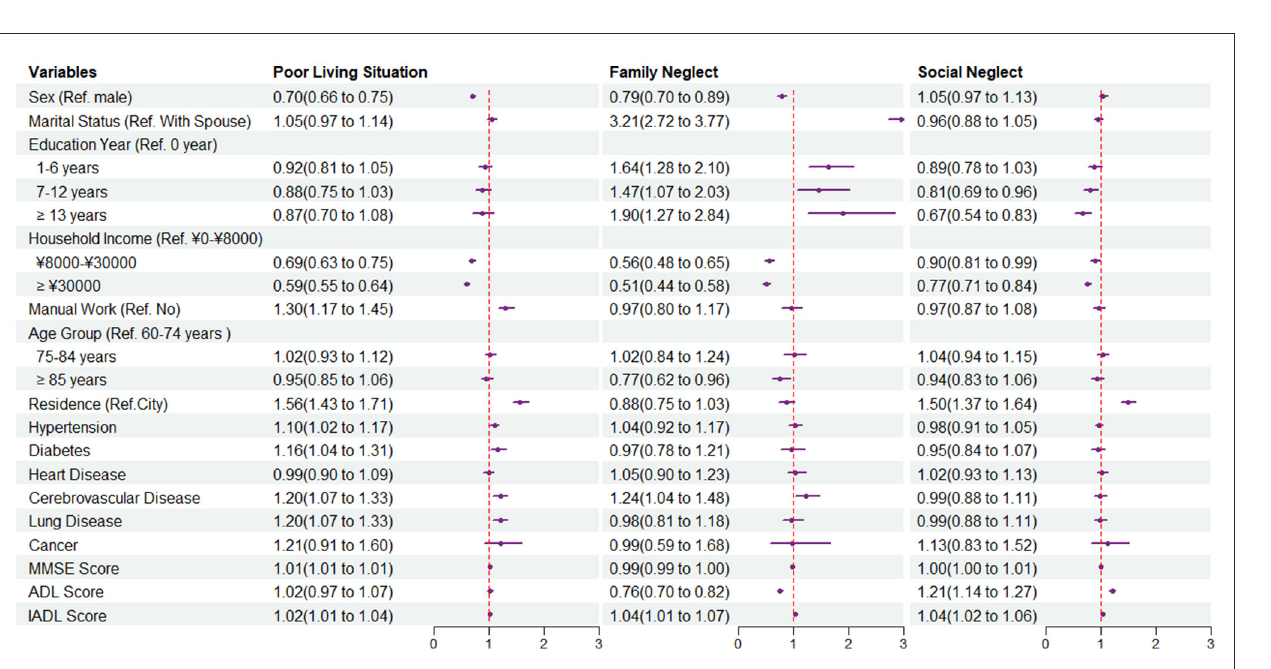
FIGURE3 Forest plot of odds ratios (ORs) and 95% confidence intervals of each characteristic in poor living situation, family neglect, and social neglect by multivariate logistic regression.